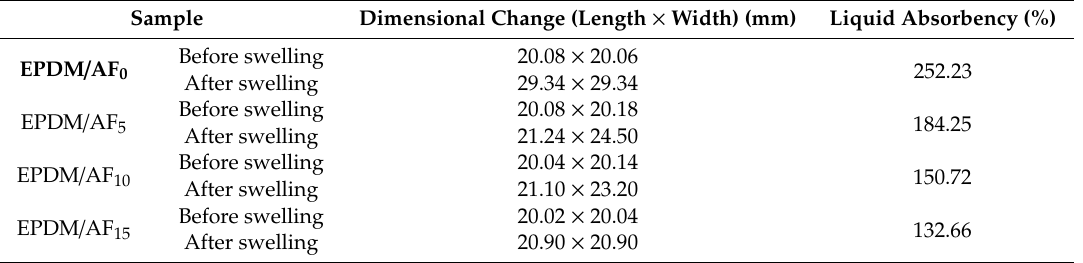
Figure 3. Digital photos of ceramifiable EPDM composite before and after swelling in pure tetrachloromethane. Table 4. Liquid absorbency and dimensional change of ceramifiable EPDM composites in pure tetrachloromethane.